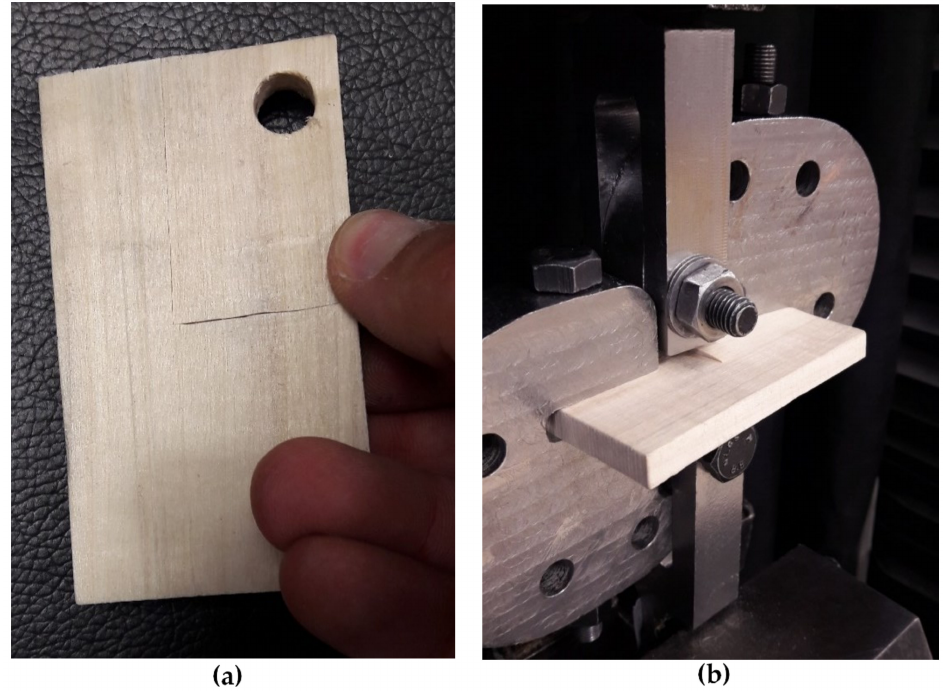
Figure 4. ( a ) K Ic test specimen after fracture; ( b ) K IIIc test specimen during loading. The fracture loads of all U-notched specimens tested are tabulated in Table 2. Addi- tionally, as an example, the force-displacement curves of U-notched specimens with three different tip radii fractured under β = 40 ◦ mixed-mode loading are plotted in Figure 5. The notch effect is evident, with an increase in the fracture load when the notch radius increases.